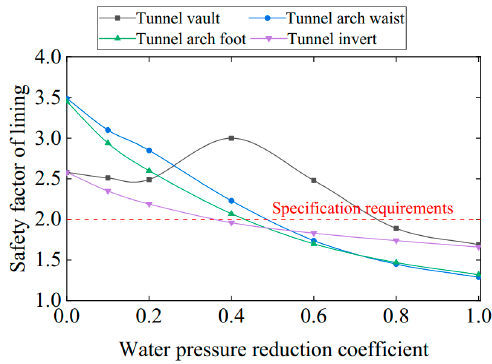
Figure 11. The safety factor varies with the reduction coefficient of water pressure.